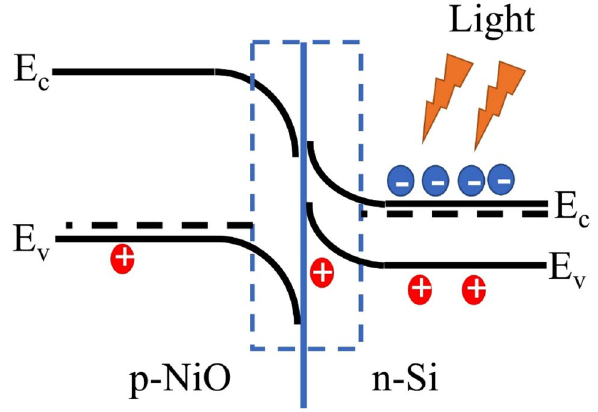
Figure 14. Schematic representations of the band energy and charge transfer for an n-Si/p-NiO heterojunction under light illumination.